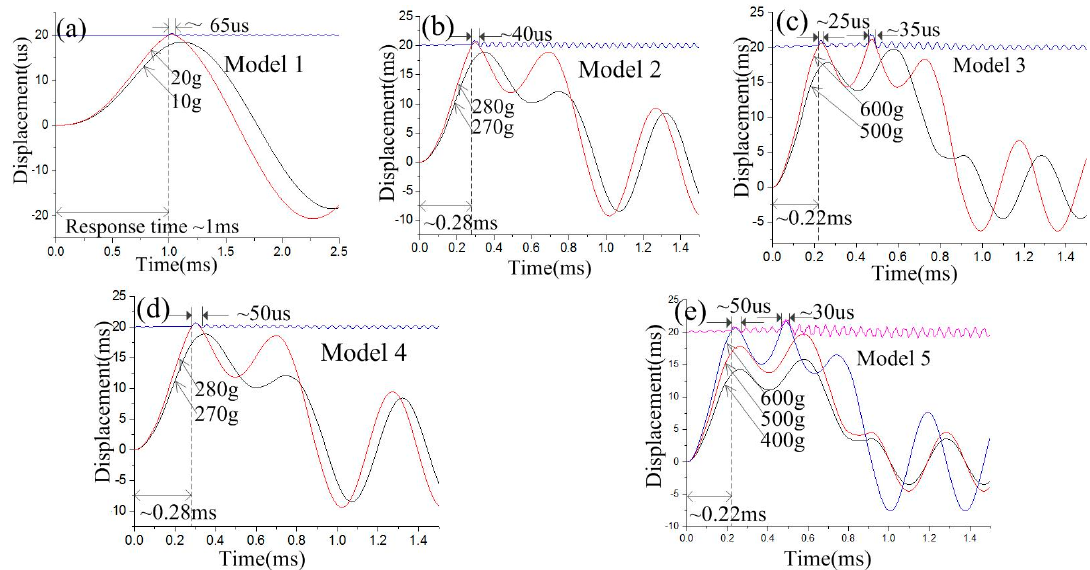
Figure 7. Dynamic response curves of inertial switch with different thresholds, and the thresholds of the designed models are ( a ) 20, ( b ) 280, ( c ) 600, ( d ) 280, and ( e ) 600 g.